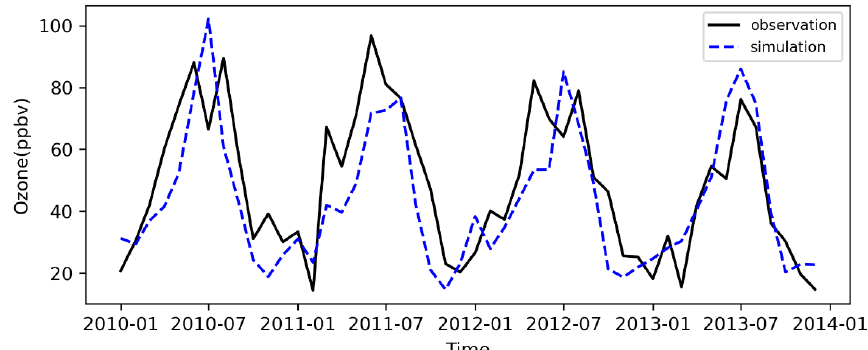
Figure 9. Observational ozone data (black solid line) and simulated ozone mixing ratio (blue dotted line) at 14:00 BJT in Beijing during 2010–2013.